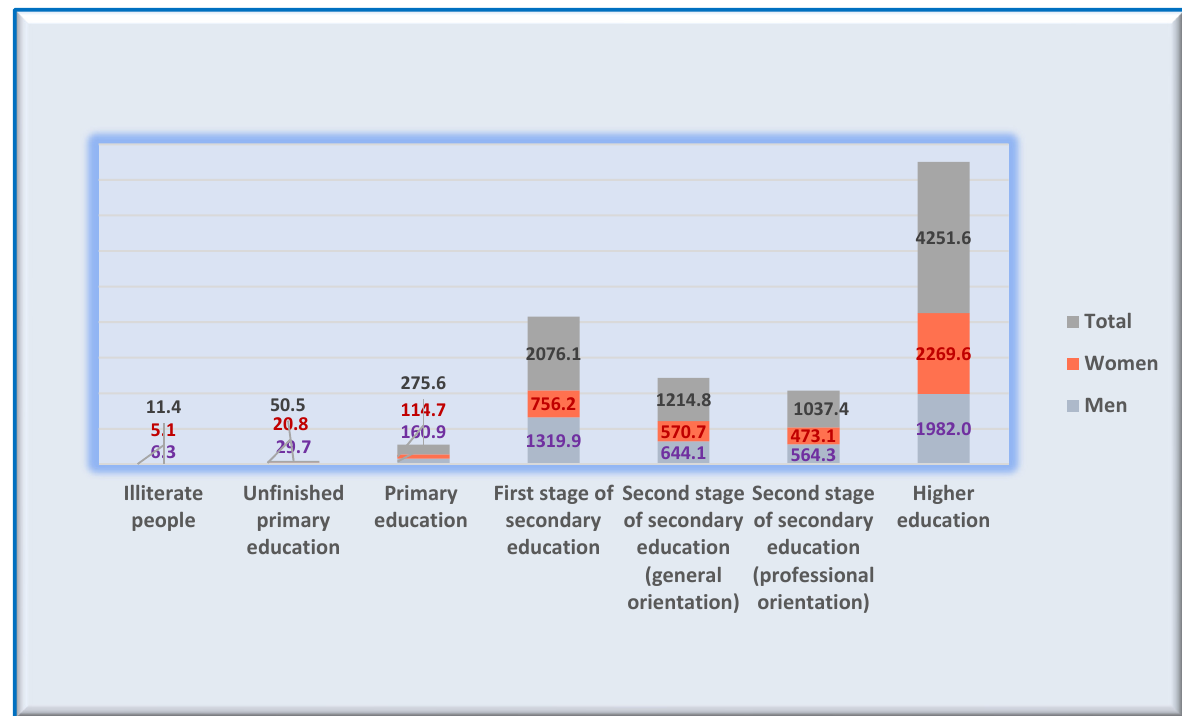
Figure 9. Employed unmarried persons by sex and educational level attained (in thousands). Source: Authors with data corresponding to the fourth quarter of 2020 provided by the Statistics National Institute ( Instituto Nacional de Estadística ). Table 8. Average annual income per worker by sex and economic sectors (in Euros).